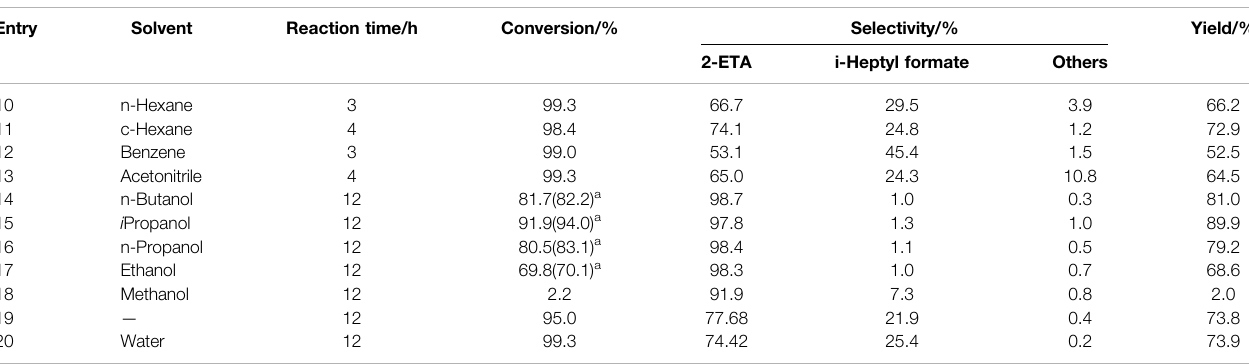
TABLE 2 | Product distribution of reaction endpoint.